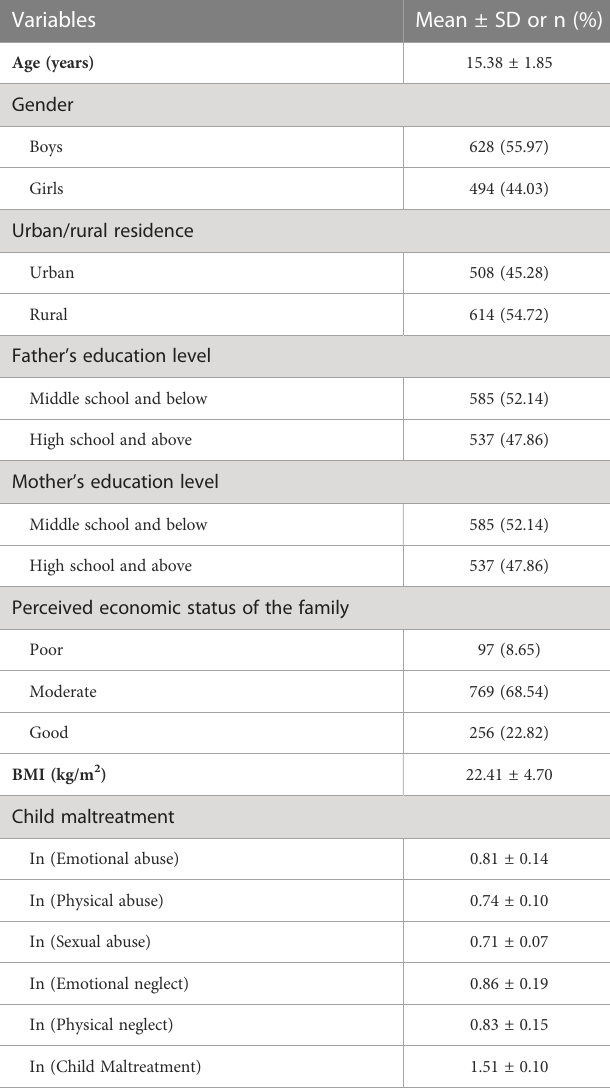
TABLE 1 Sample characteristics and descriptive